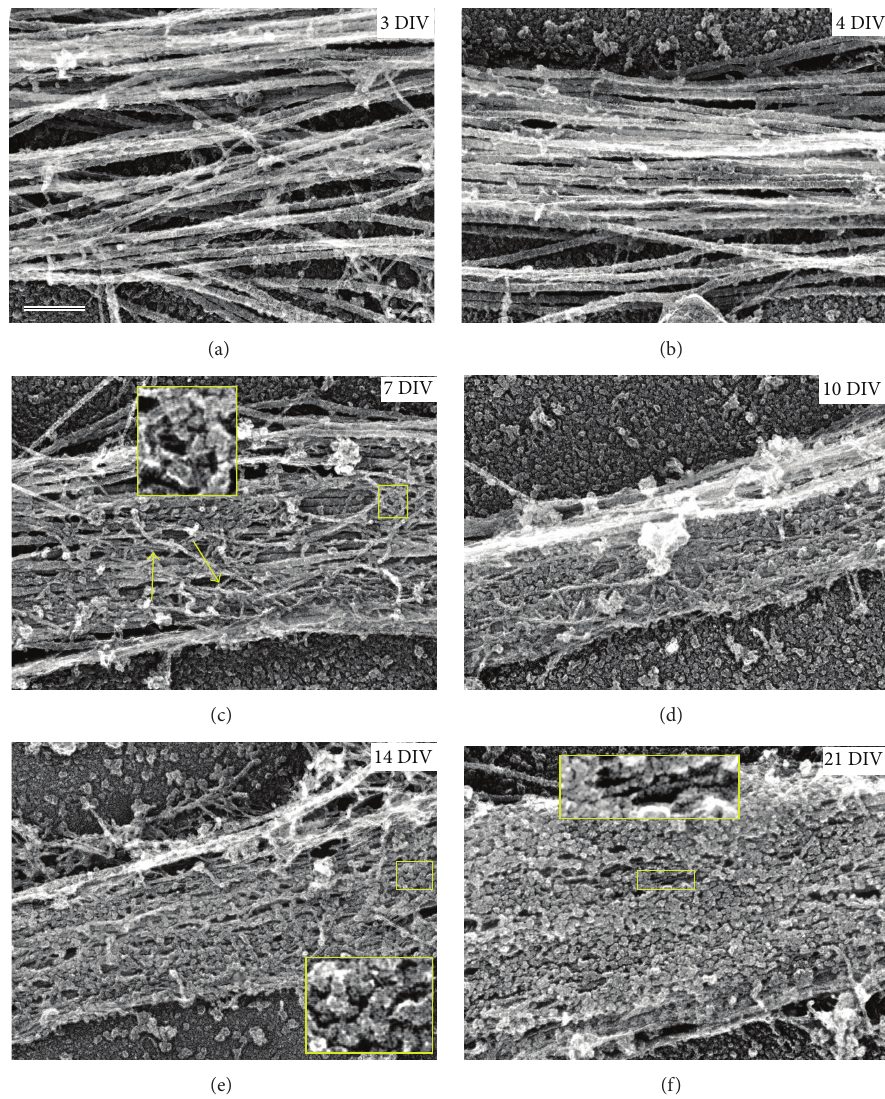
Figure 3: PREM images showing different stages of assembly of the AIS coat in hippocampal neurons. ((a)-(b)) Proximal axons of early 3 and 4 DIV neurons showing microtubules that are either loosely aligned (a) or tightly bundled (b), respectively. (c) Proximal axon of 7 DIV neuron displaying a loose fibrillar (arrows) coat containing sparse globules (inset) covering the microtubules. (d) Proximal axon of a 10 DIV neuron containing a dense fibrillar-globular coat. (e) A 14 DIV neuron displaying a dense coat containing mostly globules (inset) and few visible fibrils. (f) A 21 DIV neuron revealing a mature coat dominated by globules, although few parallel fibrils are visible (inset).